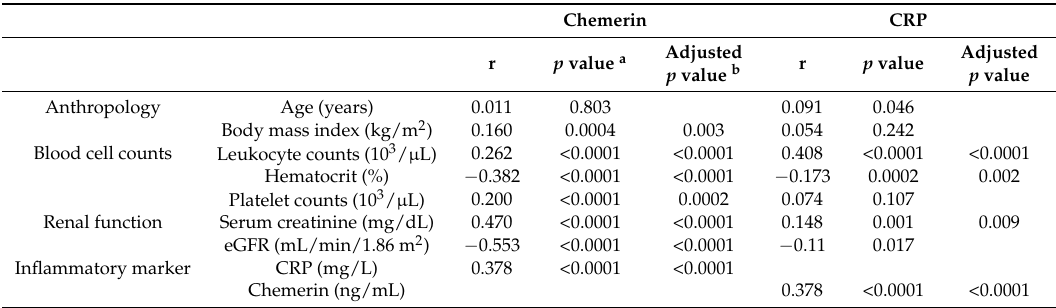
Table 2. Association between circulating chemerin and CRP levels and measurable cardiovascular risk factors in patients with coronary artery